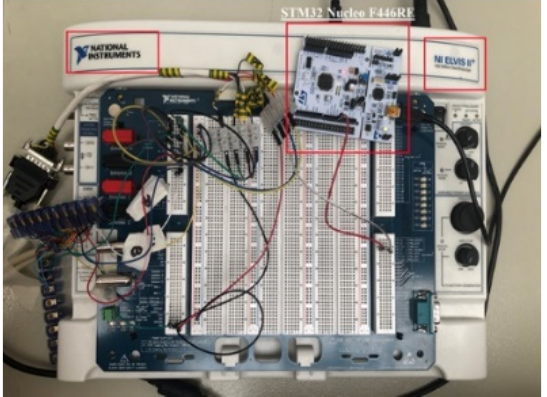
Figure 14. NI ELVIS II and STM32 Nucleo F446RE.